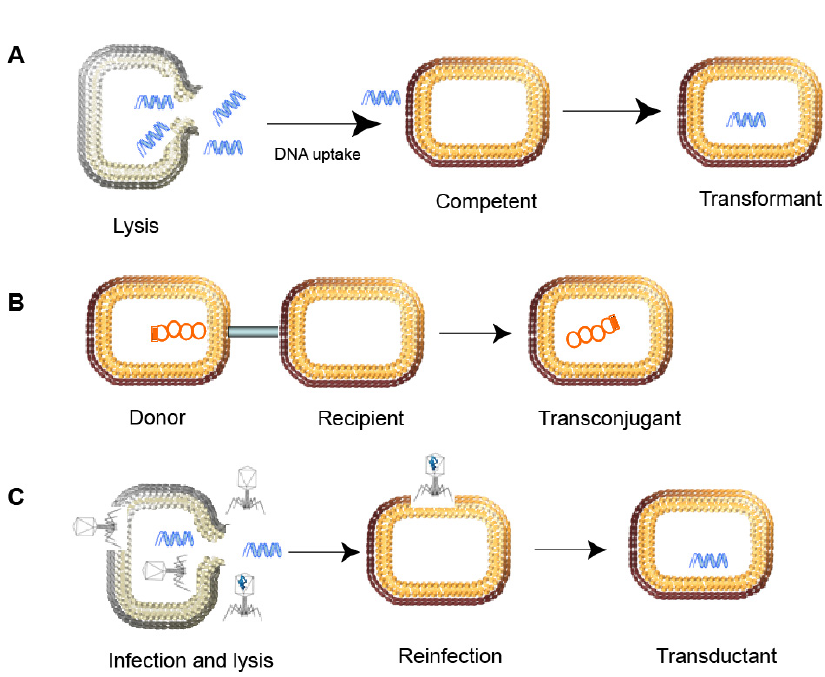
Figure 2: Main routes of horizontal gene transfer. A. Transformation takes place by a part of the bacterial population entering into a particular physiological state, mediated by a competence stimulating peptide, that makes them able to uptake ‘naked’ external DNA. Upon uptake, incoming DNA would recombine with the chromosome of the receiving cell, incorporating the new genes from the incoming DNA. B. Conjugation is mediated by cell-to-cell contacts in which the donor partner carries a plasmid (or any mobile genetic element) that encodes the genes needed for pilus assembly and the genes involved in the formation of the type IV secretion system protein complex channel. Through it, the plasmid DNA is transferred from the donor to the recipient cell. C. Transduction takes place when a phage infects a cell and is able to package pieces of chromosomal DNA rather than phage DNA. These phage particles are released after cell lysis and are able to infect other bacteria, injecting the chromosomal DNA that can be integrated into the chromosome, acquiring the new genetic